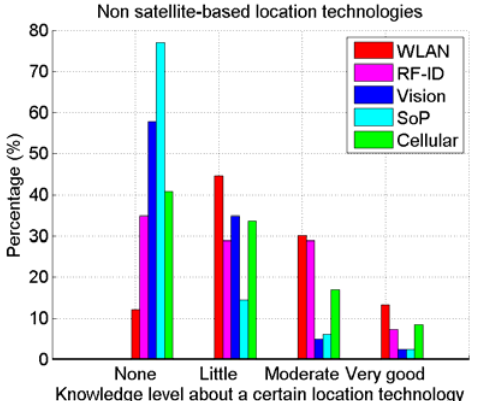
Figure 3. Familiarity level with non-satellite navigation